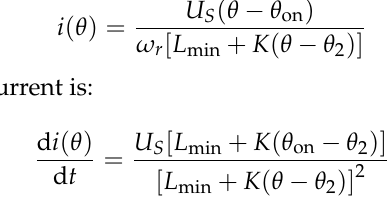
and θ on3 , respectively. The turn-off angle of the three curves is the same, and the winding currents at turn-off angle are, respectively, i θ off1 , i θ off2 and i θ off3 . θ 01 , θ 02 and θ 03 are the